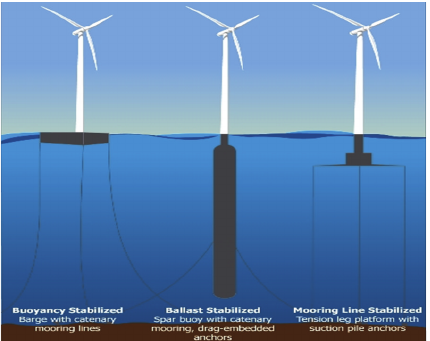
Figure 1: Floating offshore wind turbine concept. (Image from Wiki Commons.)